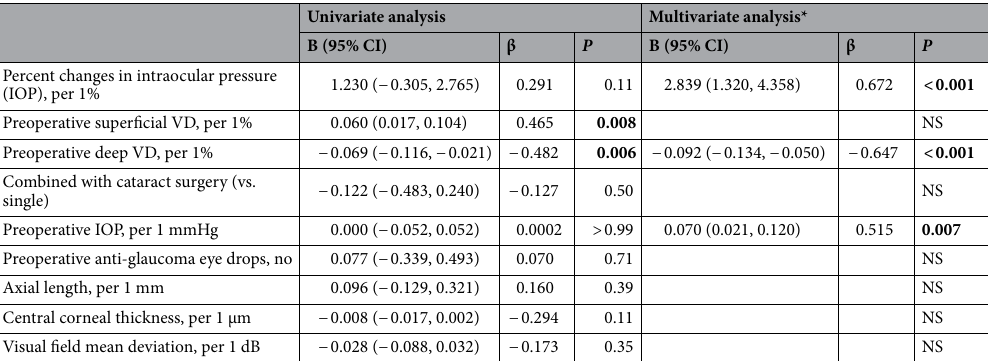
Table 3. Factors associated with the percent changes in deep vessel density (VD) (N = 31). Percent changes in IOP = (postoperative IOP 6 months after the surgery − preoperative IOP)/preoperative IOP × 100. Percent changes in deep VD = (postoperative deep VD − preoperative deep VD)/preoperative deep VD × 100. B, unstandardized regression coefficient; β, standardized regression coefficient; CI, confidence interval; IOP, intraocular pressure; NS, not significant; VD, vessel density. *Multiple stepwise regression analysis. Significant values are in bold.